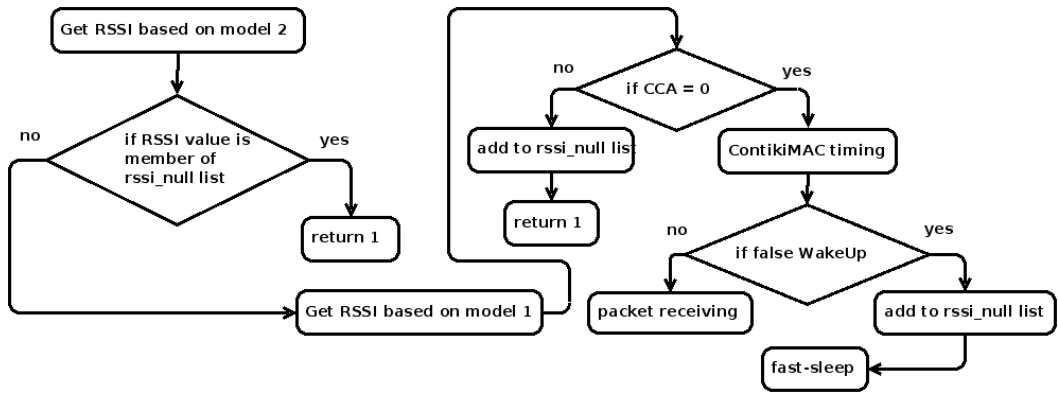
Figure 8. Diagram of the LW-CCA method.